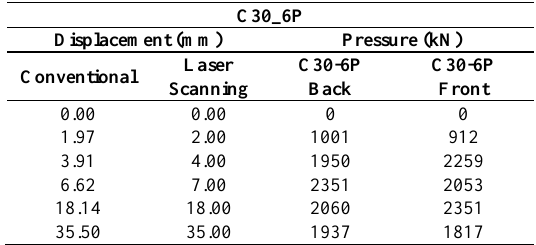
Table 1. Shortening of C30 6P